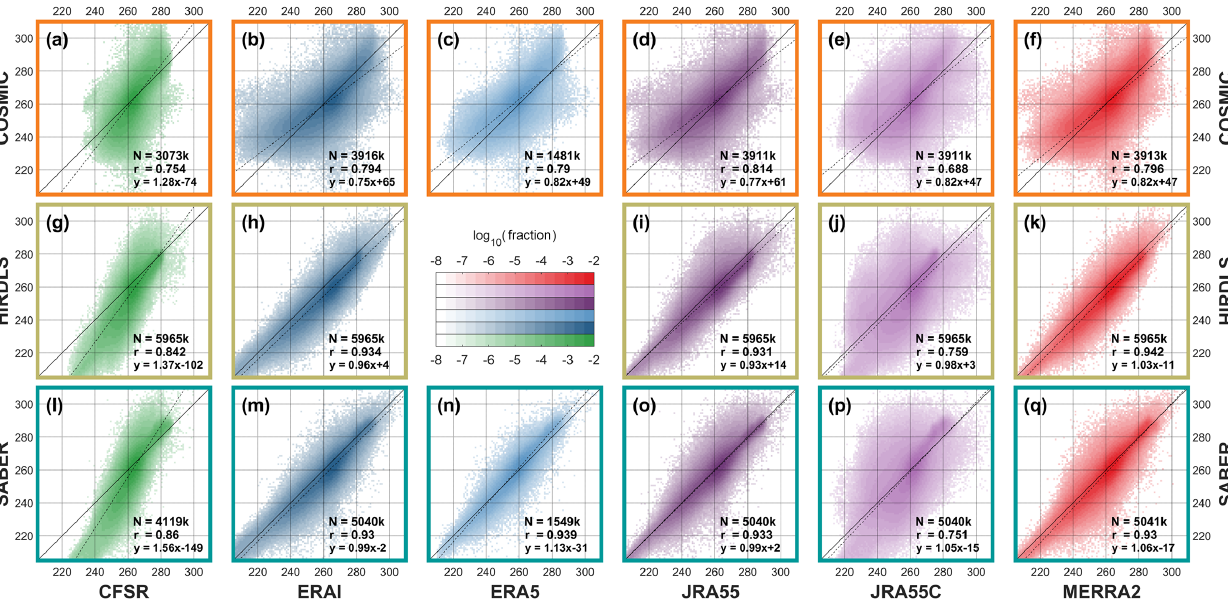
Figure 6. As in Fig. 5, but at 50km in